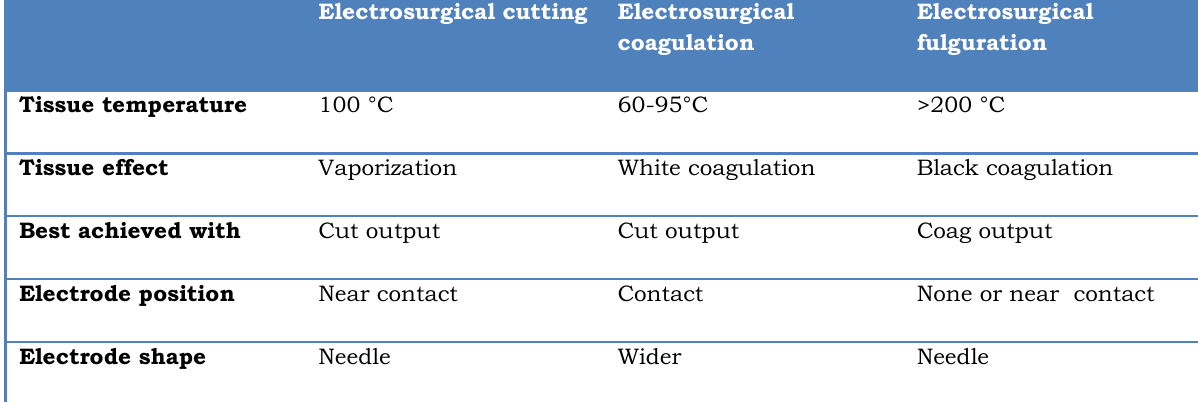
Table 3: Tissue effect and electrosurgical generator output Electrosurgical